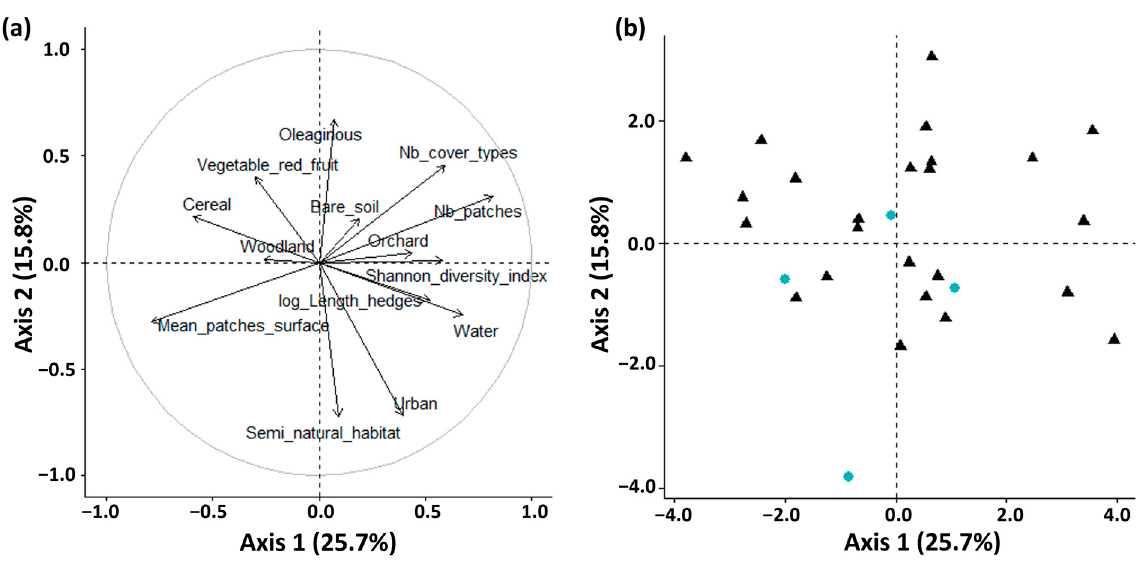
Figure 2. Principal component analysis (PCA) on the landscape metrics around the 32 greenhouse strawberry crops monitored in the present study (see Table 1 for details). ( a ): Variable vectors map in dimensions 1 and 2; ( b ) Individuals (i.e., recorded greenhouses) position in dimensions 1 and 2. Black triangles represent greenhouse crops sampled at the two sampling sessions (first session and second session), blue circles represent greenhouse crops sampled only once (second session).